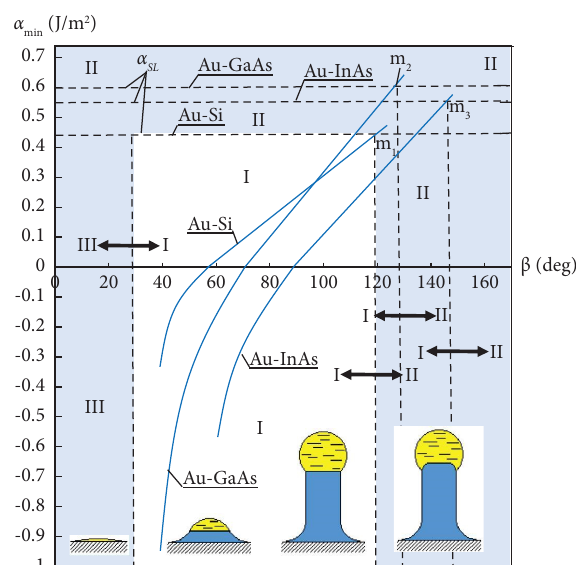
Figure 6: Diagram of dependence α min on the contact angle β at the NWs vertex in which Δ α < 0 and the monolayer absorbed (gen- erates) TPL (area